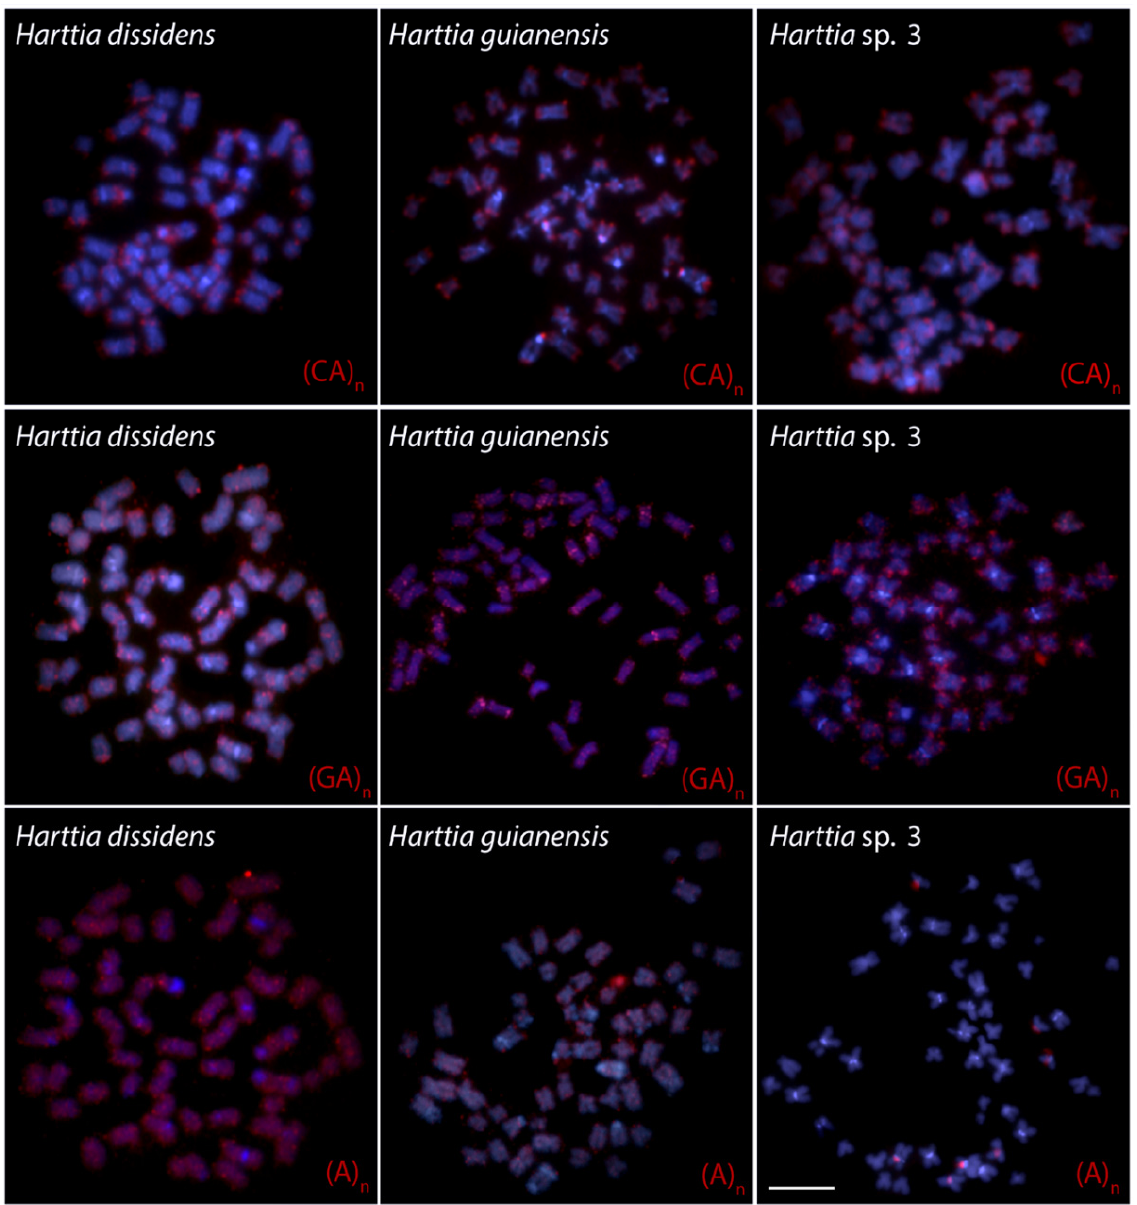
Figure 4. Chromosomal mapping of three microsatellite sequences on Harttia mitotic chromosomes. Probes (red signals): (A) 30 , (CA) 15 , and (GA) 15 . Chromosomes were counterstained with DAPI (blue). Scale bar = 10 µm.